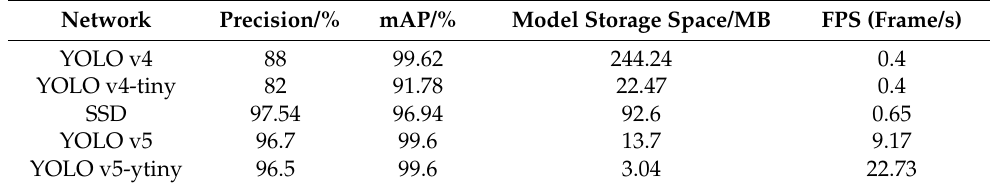
Table 3. Comparison of comprehensive evaluation of algorithms.